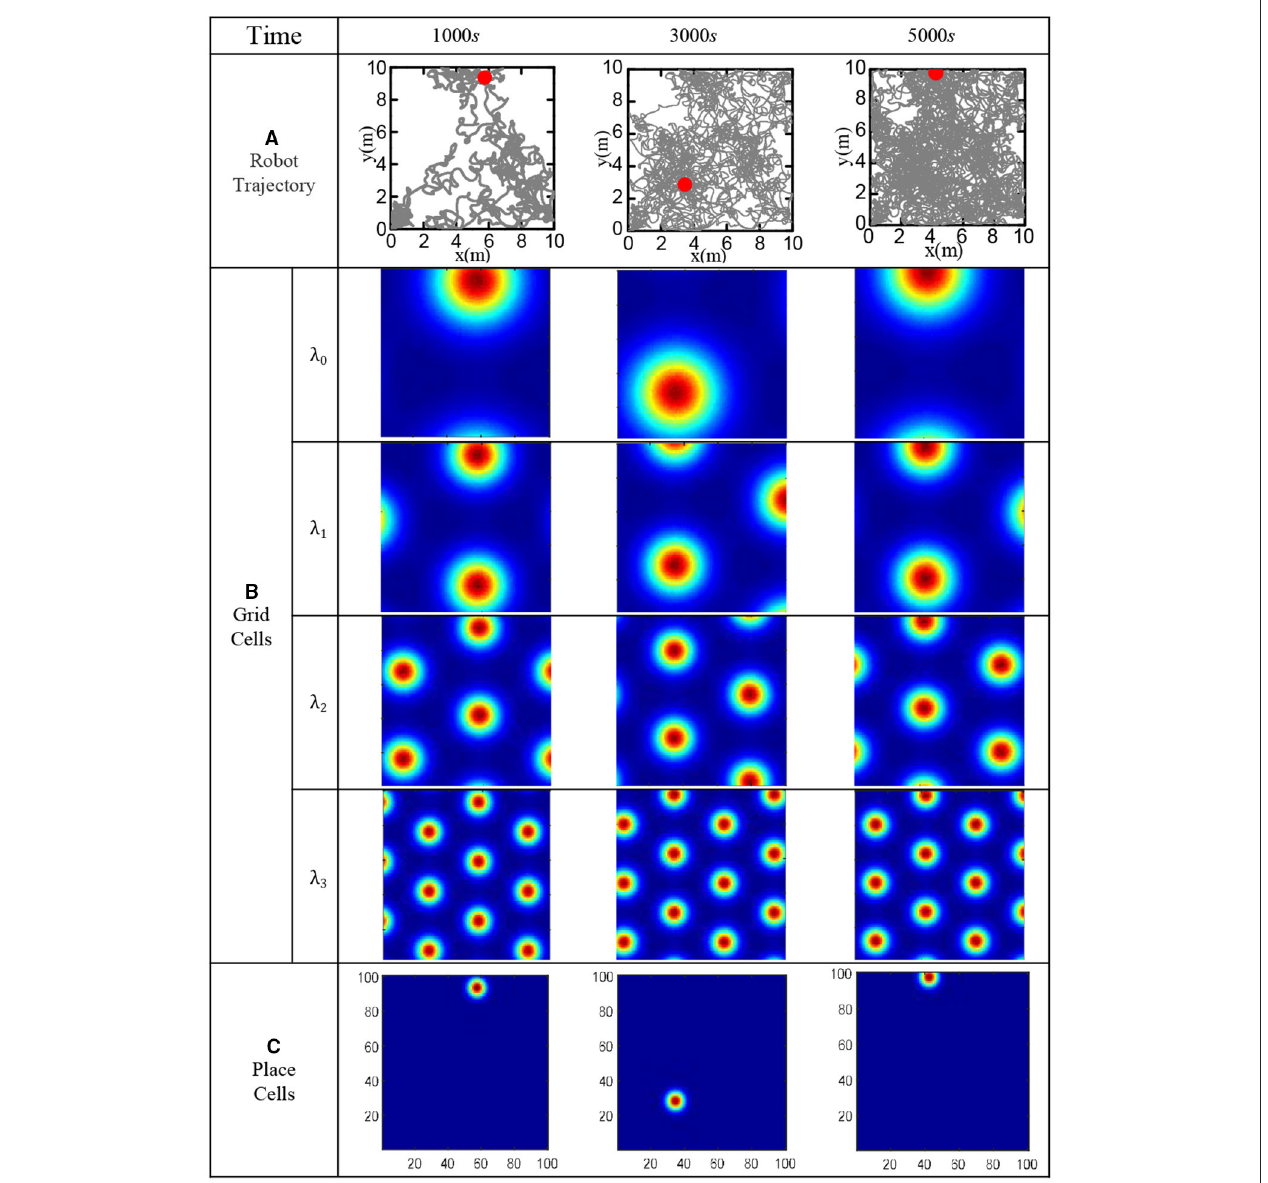
FIGURE 15 | Functional verification of robot bionic cognitive model. (A) The gray line is the robot’s trajectory, and the red dot is the robot’s position at the current time. (B) The population firing pattern of grid cell neural plate at each time and each scale. (C) Firing pattern of place cells at each time.